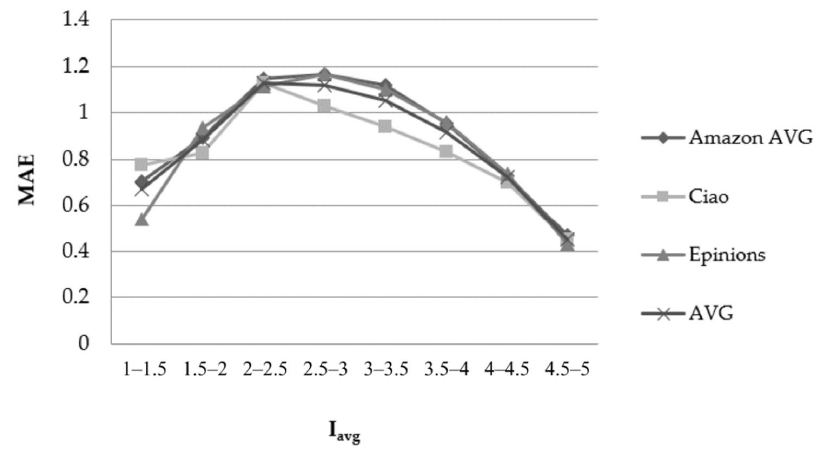
Figure 3. Effect of the I avg –feature in the rating prediction MAE when using the PCC user similarity metric.